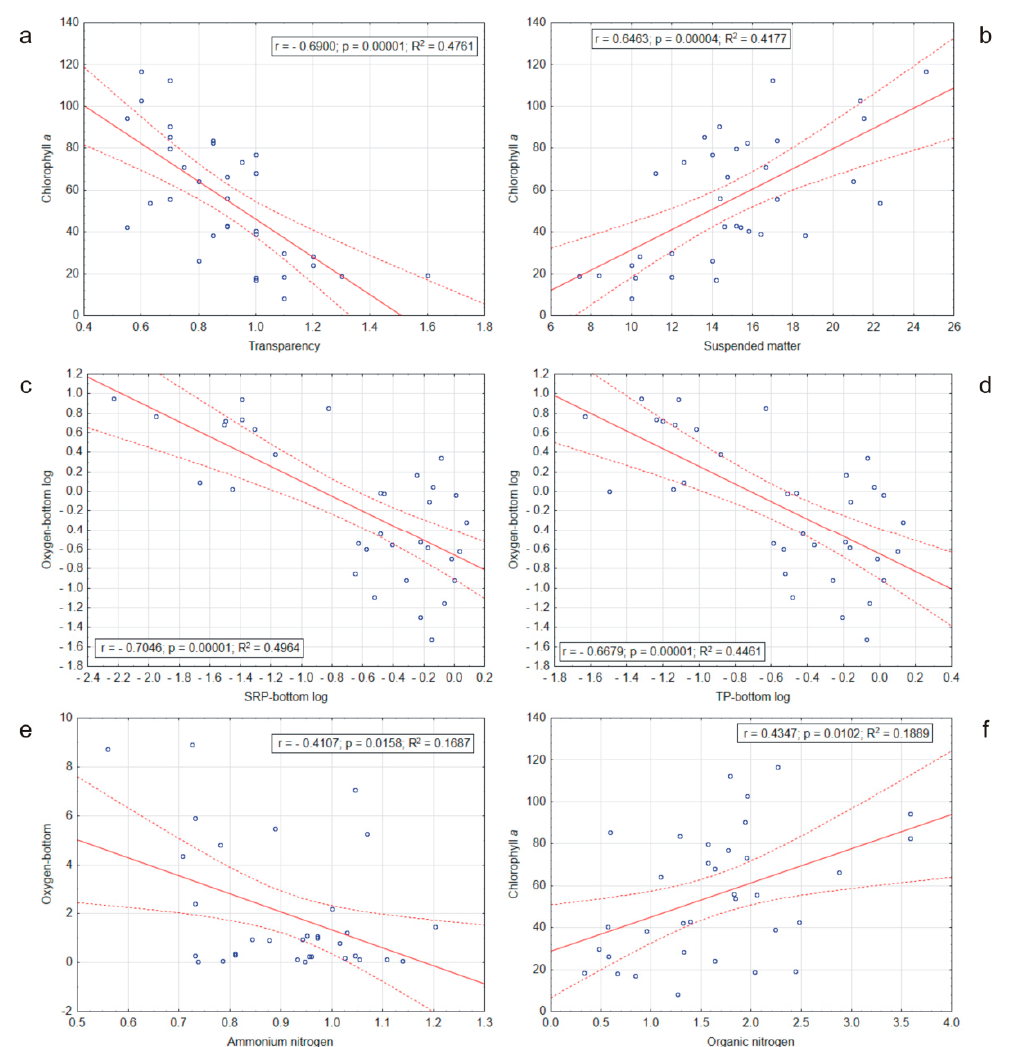
Figure 7. The data of multiple regression for chlorophyll a and transparency ( a ), chlorophyll a and suspended matter ( b ), SRP and oxygen over bottom ( c ), TP and oxygen over bottom ( d ), ammonium nitrogen and oxygen over bottom ( e ) and chlorophyll a and organic nitrogen near the surface ( f ).